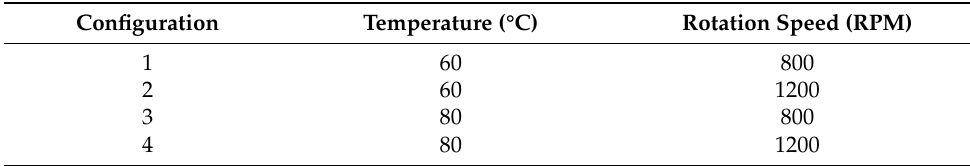
Table 9. Configuration parameters.